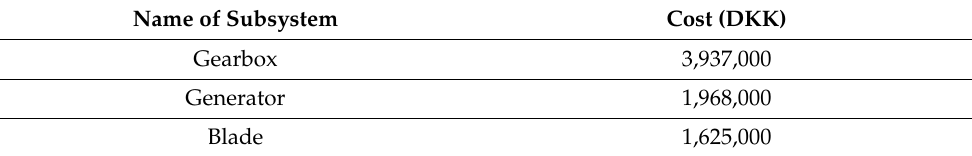
Table 1. Subsystem Replacement Cost of a 5 MW Offshore Wind Turbine